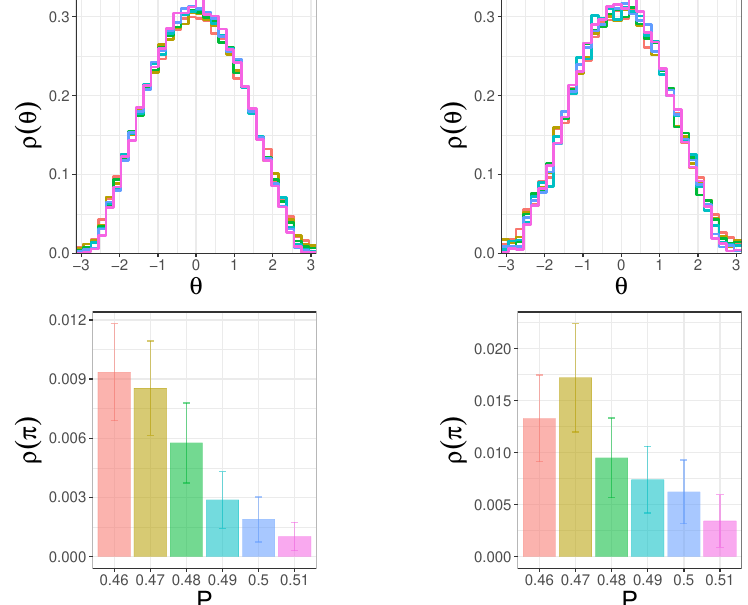
Figure 15. Full BMN model: [Top] The histogram of the Polyakov line phases for [ P − ∆ P, P +∆ P ] , where ∆ P = 0 . 005 and P = 0 . 46 , 0 . 47 , · · · , 0 . 51 . [Bottom] ρ ( π ) or more precisely, the height of the right-most bin in the histogram. Top and bottom rows use the same color for the same value of P . [Left] T = 0 . 756 (close to T ) for µ = 3 . 0 , N = 32 , L = 12 . The Myers term was not constrained in 1 this simulation. [Right] T = 1 . 18 (close to T ) for µ = 5 . 0 , N = 32 , L = 24 . 1